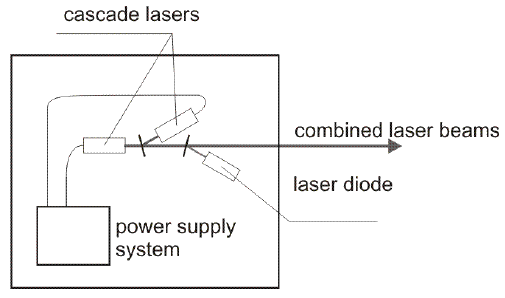
Figure 3. Diagram of the laser source.